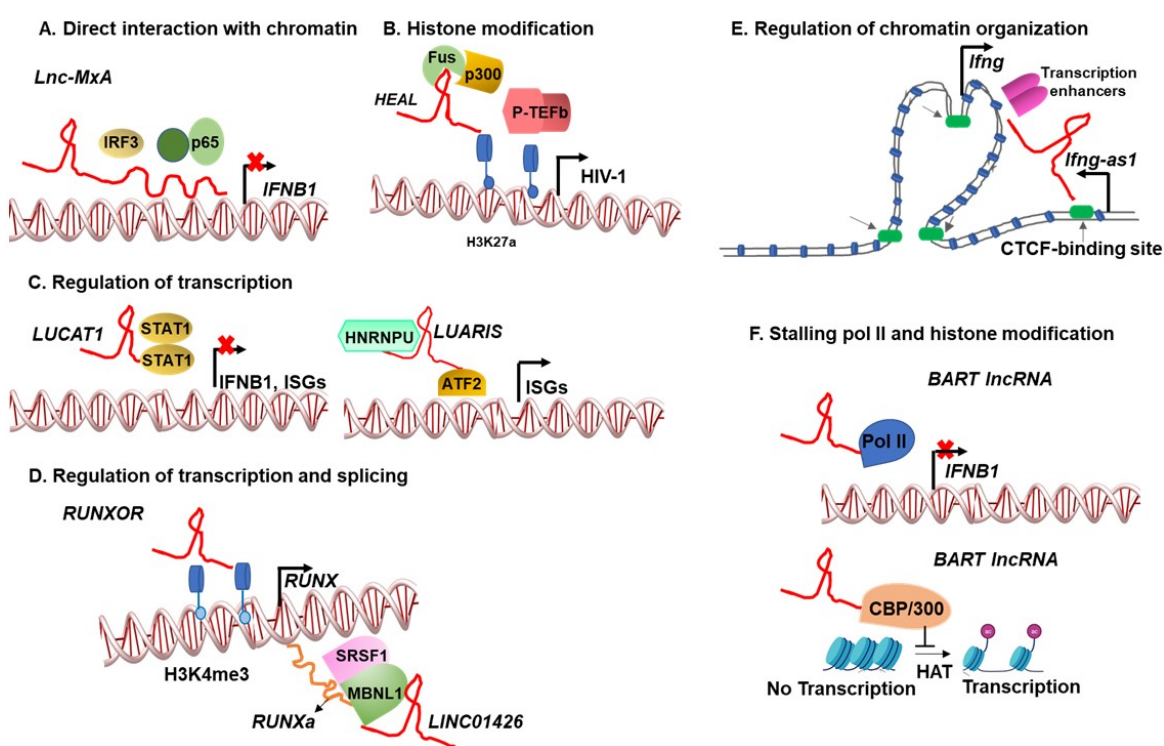
Figure 1. Virus-induced nuclear lncRNAs regulate gene expression using various mechanisms, such as ( A ) Direct interaction of Lnc-MxA with the promoter region of IFNB1, which inhibits recruitment of transcription factors and IFNB1 transcription; ( B ) HEAL lncRNA recruits histone-modifying proteins and transcription elongation factors at HIV promoter and enhances HIV transcription; ( C ) LUCAT1 sequesters STAT1 transcription factor and inhibits IFNB1 transcription, whereas LUARIS localizes ATF2 to the promoter region of interferon-stimulated genes (ISGs) and enhances their expression; ( D ) RUNX mRNA transcription and isoform expression are regulated by neighboring lncRNAs RUNXOR and LINC01426 ; ( E ) Ifng-as1 transcript is likely to enhance Ifng expression by recruiting and enriching transcriptional enhancers (transcription factor or chromatin modifiers). In addition, the Ifng-as1 locus impacts the chromatin organization independent of the Ifng-as1 transcription or lncRNA sequence through a CTCF-binding site encoded within the Ifng-as1 gene region; ( F ) BART lncRNA stalls Pol II at the promoter region of IFNB1 and inhibits its transcription. BART lncRNA also associates with CREB-binding protein (CBP/300) and inhibits its histone acetylation activity, thus inhibiting gene